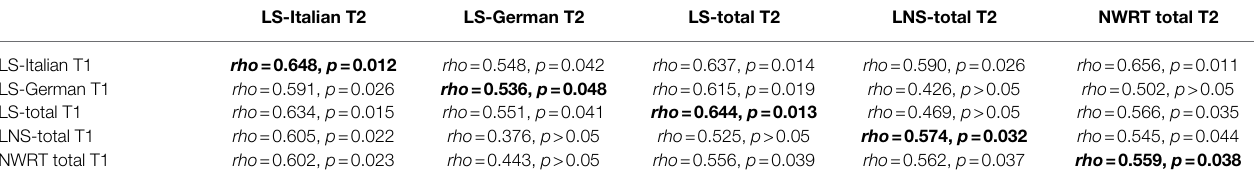
Correlations between same-scale scores are highlighted in